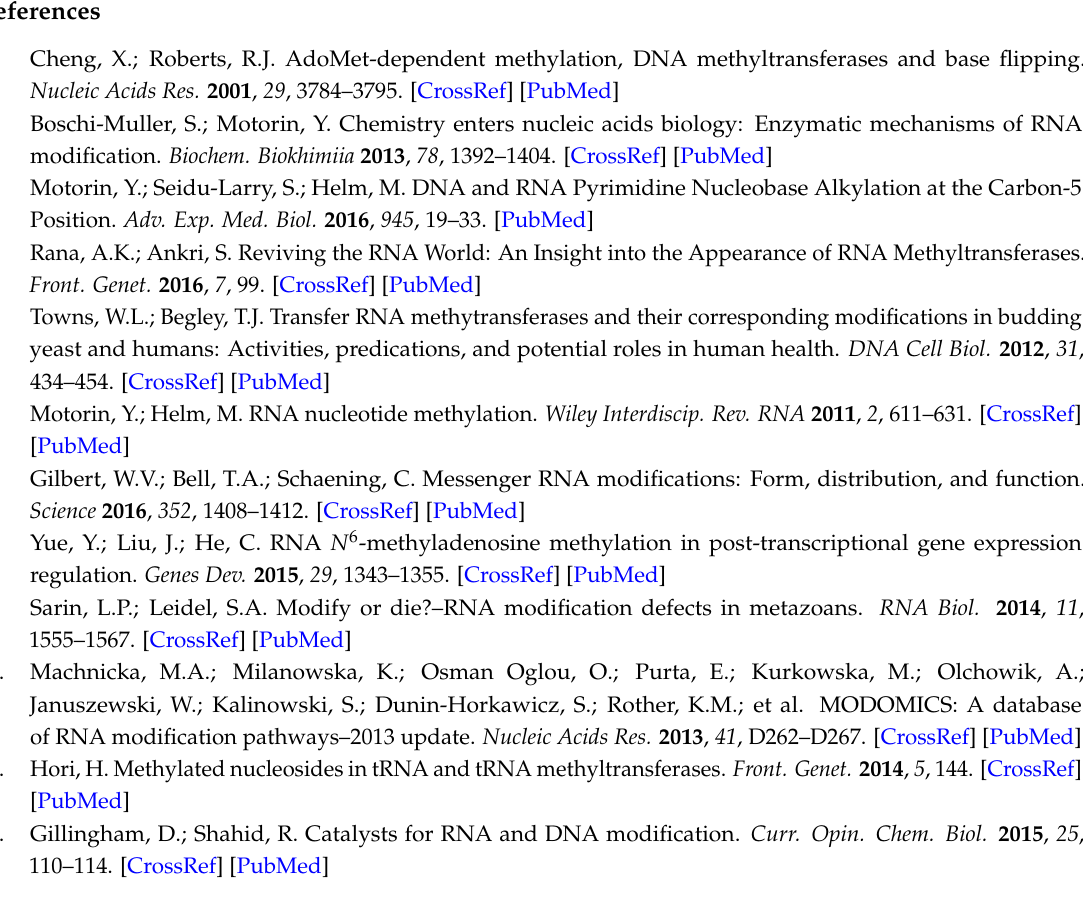
Supplementary Materials: The following are available online at http://www.mdpi.com/2218-273X/7/1/11/S1, Supplementary Materials and Methods, Figure S1: Levenshtein distances between tRNA gene (tDNA) sequences from E. coli and S. cerevisiae , Figure S2: False-positive hits observed in the E. coli transfer RNA (tRNA) cleavage profiles, Figure S3: Quantification of Gm in E. coli tRNA Met by liquid chromatography coupled to tandem Table S1: Initial and collapsed E. coli tDNA dataset, Table S2: Initial and collapsed S. cerevisiae tDNA dataset, Table S3 :Number of sequencing reads used for the RiboMethSeq analysis of different